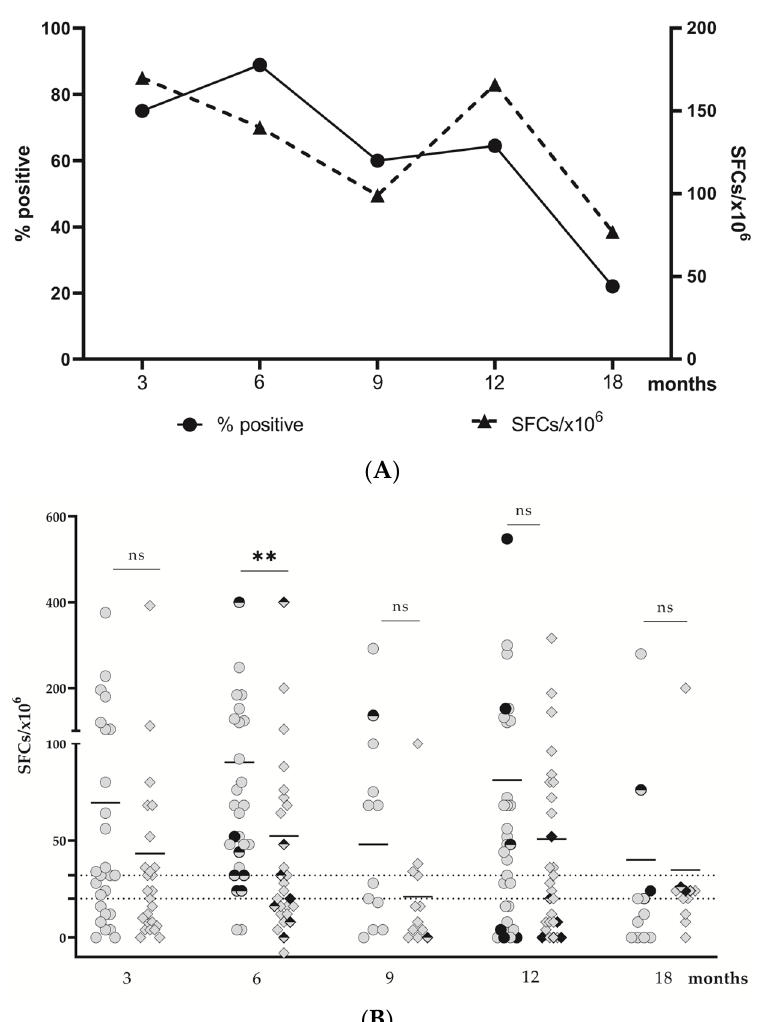
Figure 1. Dynamics of SARS-CoV-2-specific T-cell responses until 18 months post-infection. ( A ) Share of positive responses (thick line) and mean numbers of SFC/10 6 PMBCs (dotted line). ( B ) Individual values for the number of S1- (circles) and N- (diamonds) specific IFN- γ secreting T cells. The dotted line corresponds to the cut-off level (32 SFCs/10 6 PMBCs). Donors vaccinated within 6 months before sampling are designated with full black circles, and those vaccinated beyond 6 months before sampling with semi-black circles, with either BNT162b2 (Pfizer-BioNTech) or ChAdOx1 (Oxford/AstraZeneca); ** p < 0.01.